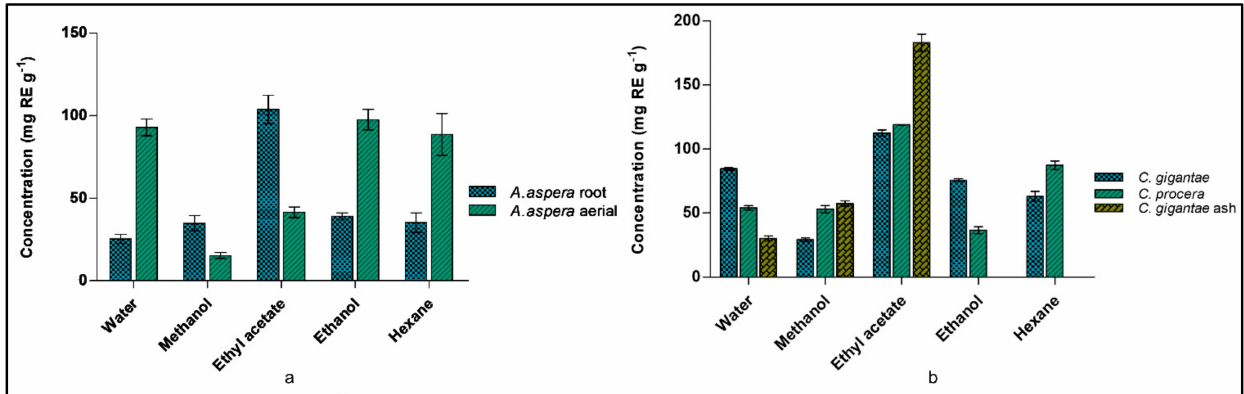
Figure 1. Total flavonoid content determination ( a ) A. aspera ( b ) C. gigantea and C. procera